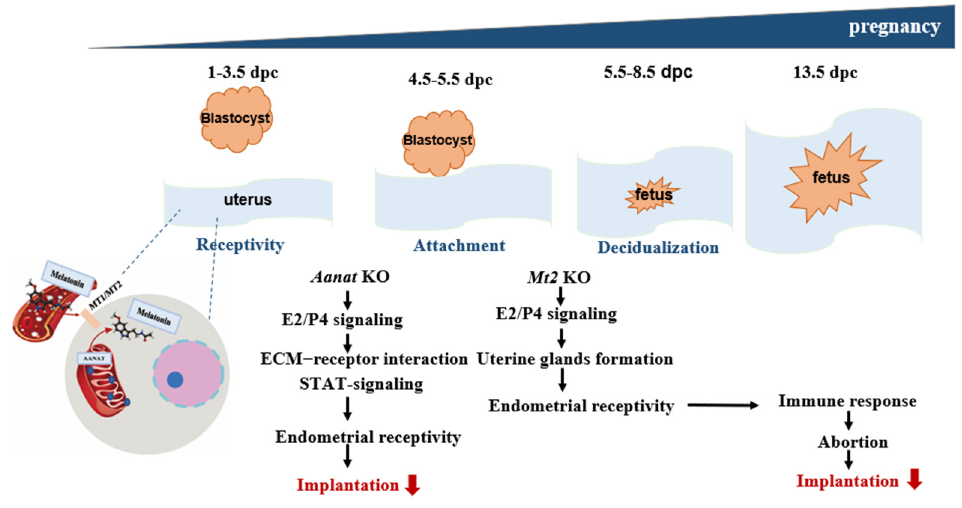
Figure 6. Schematic of the melatonergic systems (AANAT, MT2) that are active during embryo im- plantation.